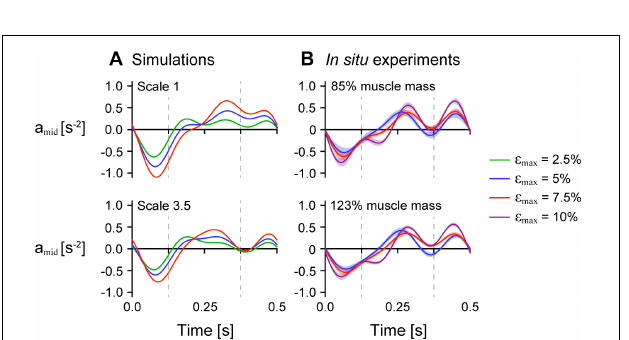
FIGURE 8 | Normalised acceleration midway along the muscle’s length over time across strain conditions. Normalised tissue acceleration in the x -direction of a point midway along the muscle’s length a mid over time for simulations with initial pennation angle β 0 of 15.3 ◦ (A) and in situ experiments (B) . The dashed vertical bars at 0.125 s and 0.375 s indicates the times when the muscle was at its longest and shortest lengths, respectively. a mid was normalised using the x distance between the centre point and the moving end of the muscle at rest for the simulations and between the inserted pin and the moving end of the in situ muscle at rest for the experiments. The maximum normalised excitation was 1 for the simulations and the in situ muscle was supramaximally stimulated to activate all the muscle fibres. The shaded intervals in (B) show the standard error of the mean at each time point.